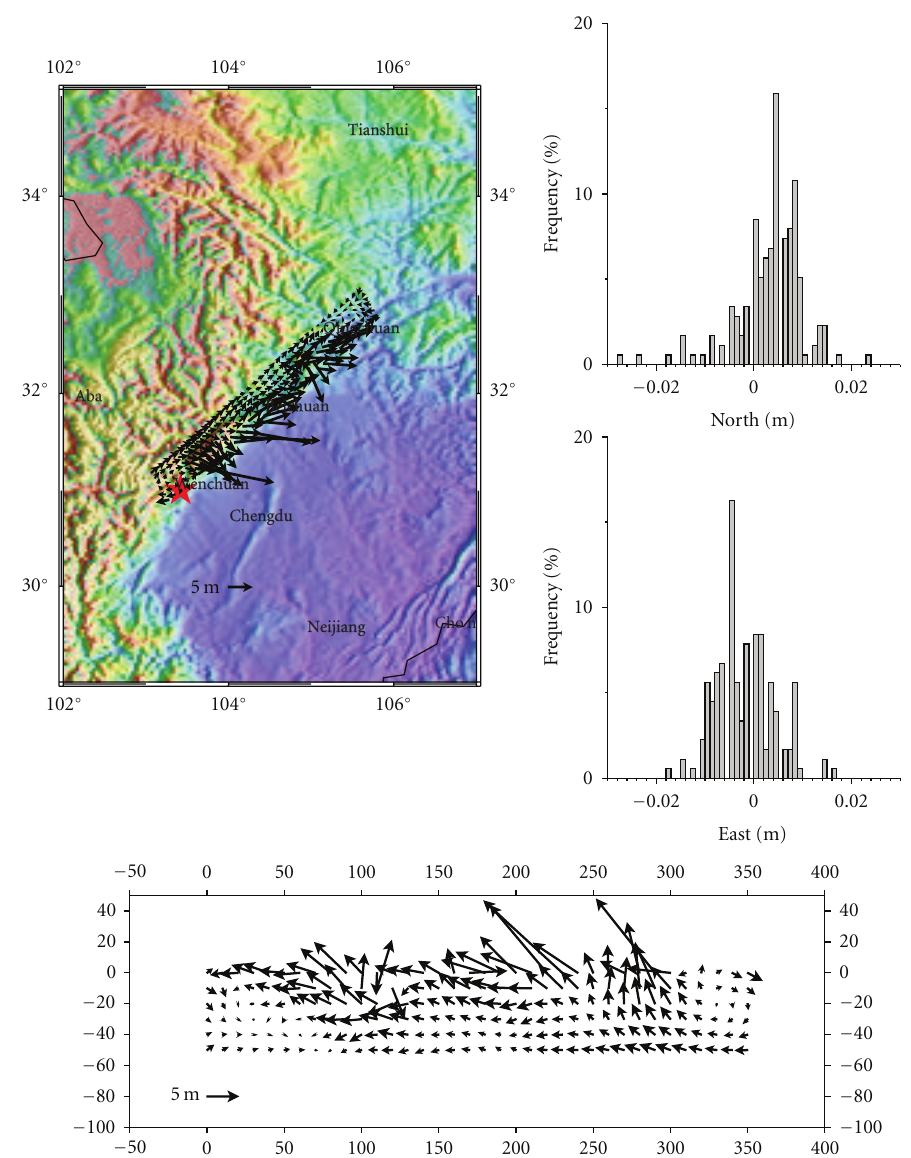
Figure 4: Fault slip distribution by inversion of horizontal coseismic displacements. Top left side is fault slip distribution in horizontal geodetic coordinate system, and bottom is fault slip distribution in the fault plane, and the circles at the heads of arrows show the 95% uncertainty error ellipses. Top right side is the histogram of data